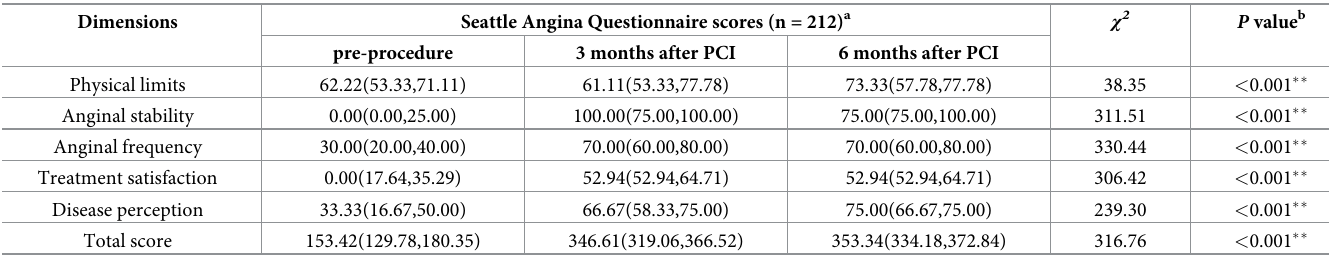
Table 3. SAQ scores at before, 3 and 6 months after